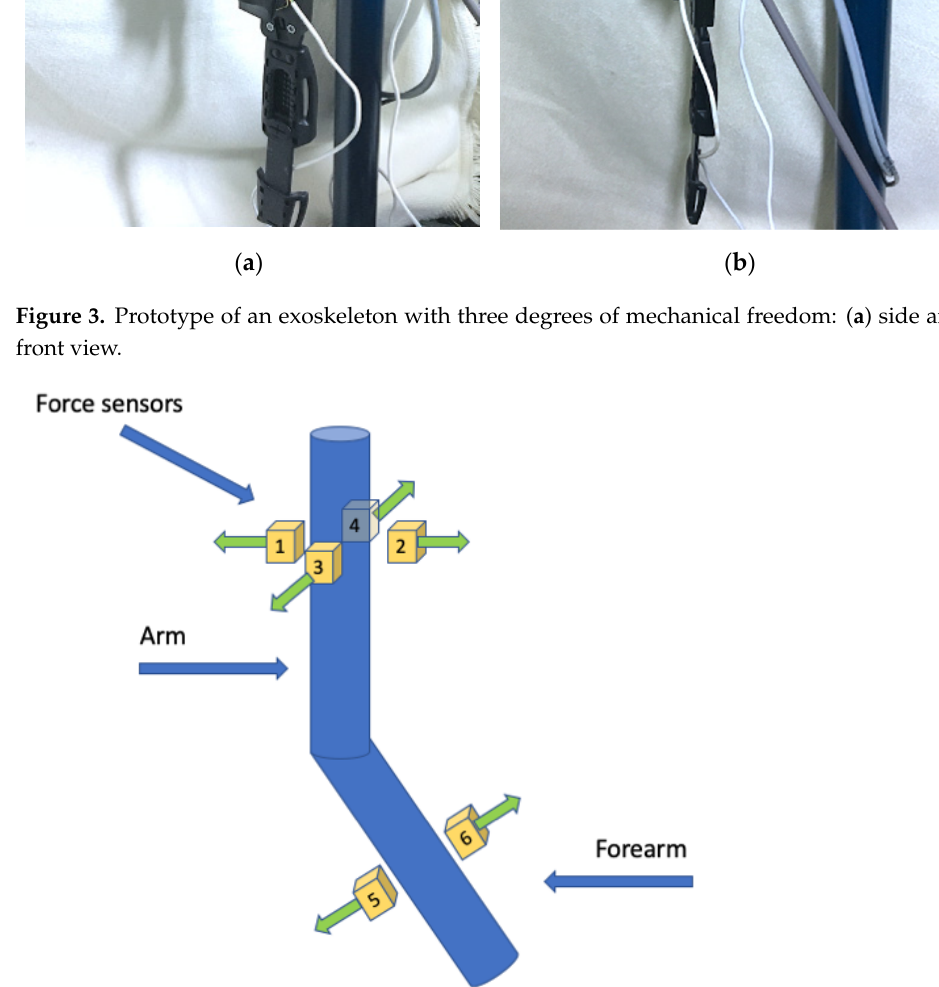
Figure 4. Distribution of force sensors (1–6) on individual components of the upper limb in the prototype system.